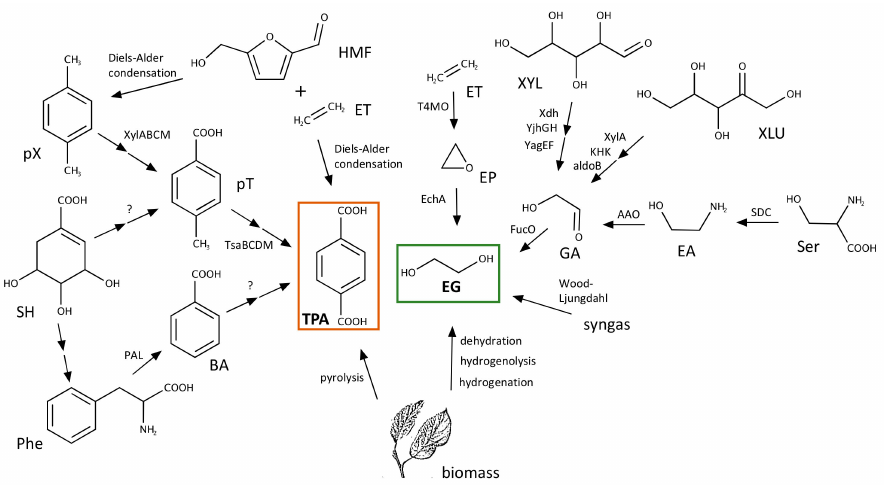
Figure 5. Selected pathways and processes used to produce TPA and EG from renewable sources. The names of the molecules and abbreviations are: p -xylene, pX; p -toluate, pT; shikimate, SH; phenylalanine, Phe; benzoate, BA; 5-(hydromethyl)furfural, HMF; ethylene, ET; ethylene oxide, EP; xylose, XYL; xylulose, XLU; glycoaldehyde, GA; serine, Ser; ethanolamine, EA. If known, the names of enzymes / processes responsible for the di ff erent conversions are shown next to the